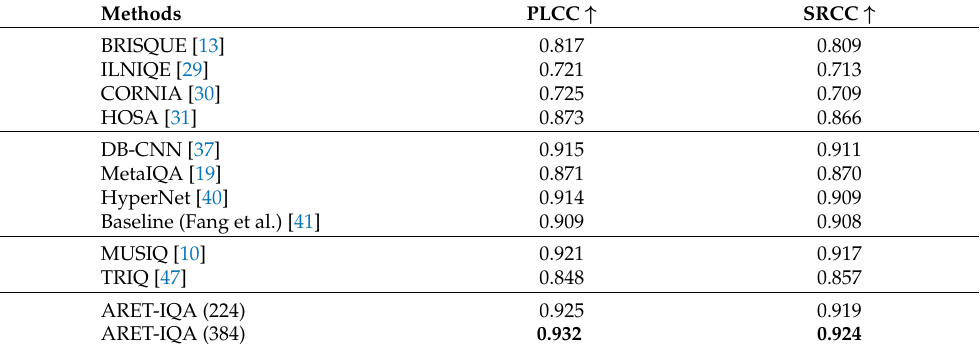
Table 2. Comparison results (PLCC and SRCC) of the proposed method with several state-of-the-art IQA methods on the SPAQ database [27], where the best results for each database are shown in bold. In our ARET-IQA model, the input images were resized to two default resolutions for the Transformer network: 224 × 224 (ARET-IQA (224)) and 384 × 384 (ARET-IQA (384)).